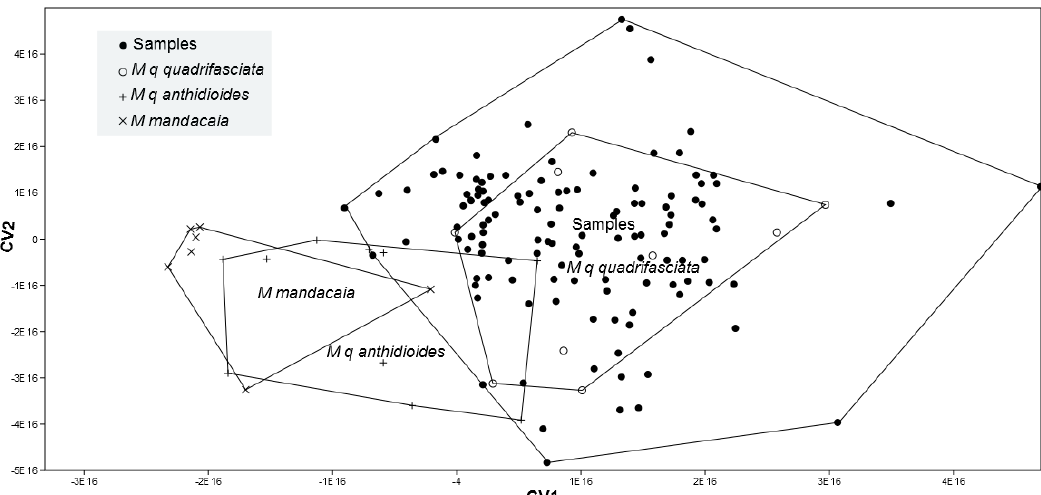
Fig 3. Analysis of the Canonical Variables showing comparison of 140 samples form 14 colonies found at the mouth of the river São Francisco with the standard specimens Melipona quadrifasciata quadrifasciata , Melipona quadrifasciata anthidioides and Melipona mandacaia . Overlap - ping of the samples with the standard specimen M.quadrifasciata quadrifasciata can be seen. CV1: canonical variable 1; CV2: canonical variable